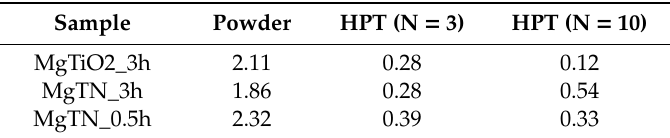
Table 1. Intensity ratios of the (101) and (002) Mg reflections for the di ff erent composite powders and HPT